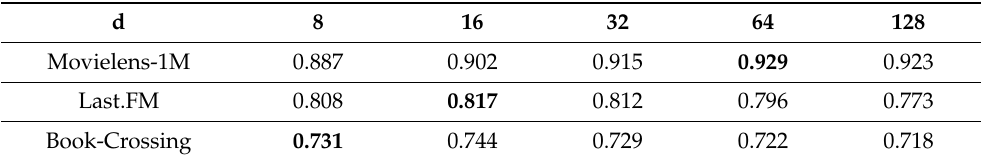
Table 3. The impact of different embedding dimensions on AUC indicators. The best results are in